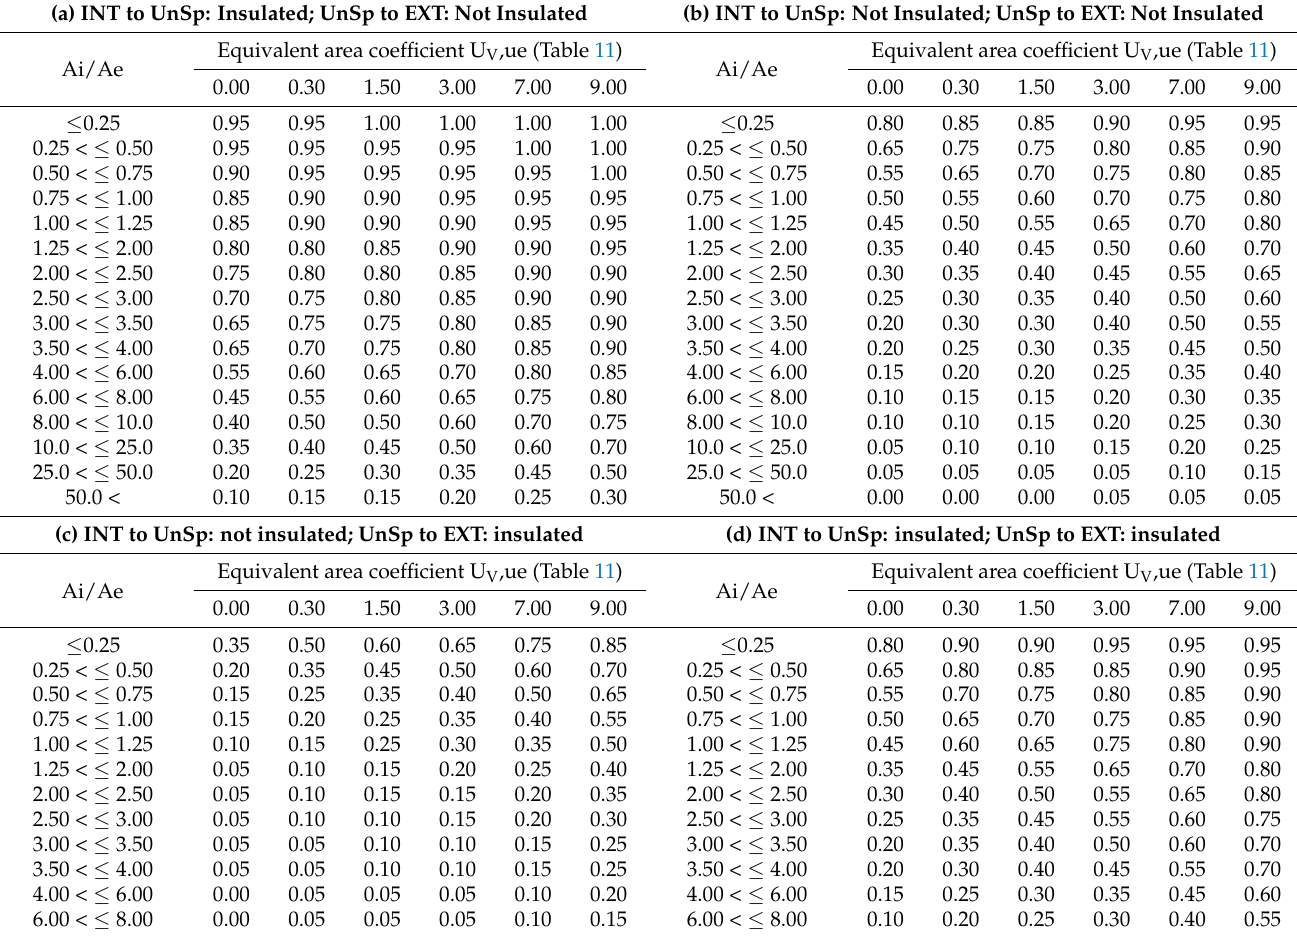
Table 10. Values for the adjustment factor (b), set by the RE2020 (adapted from [16]). (b) INT to UnSp: Not Insulated; UnSp to EXT: Not